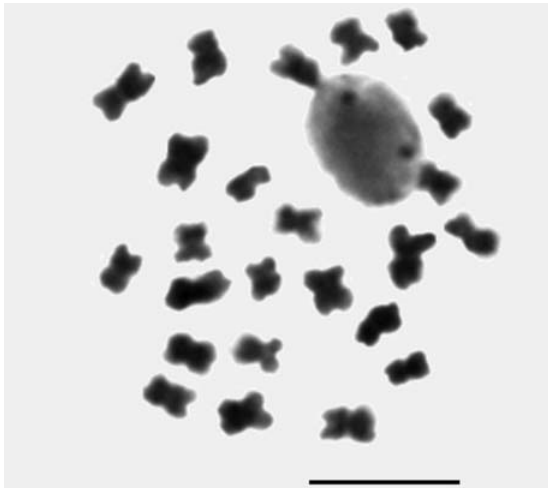
Figure 2 - Metaphase chromosomes (2n = 24) obtained from rosewood root tip cells pre-treated with 5 mM the herbicide oryzalin and Giemsa stained.Thenucleolarorganizingregioncanbeseenintheshortarmofthe chromosome pair with secondary constrictions and satellites associated withthenucleolus.Notethatafteroryzalintreatmentthechromosomesare condensed as in standard C-metaphase morphology and the nucleolus re- mains attached to the secondary constriction. Bar = 5 (cid:1) m.